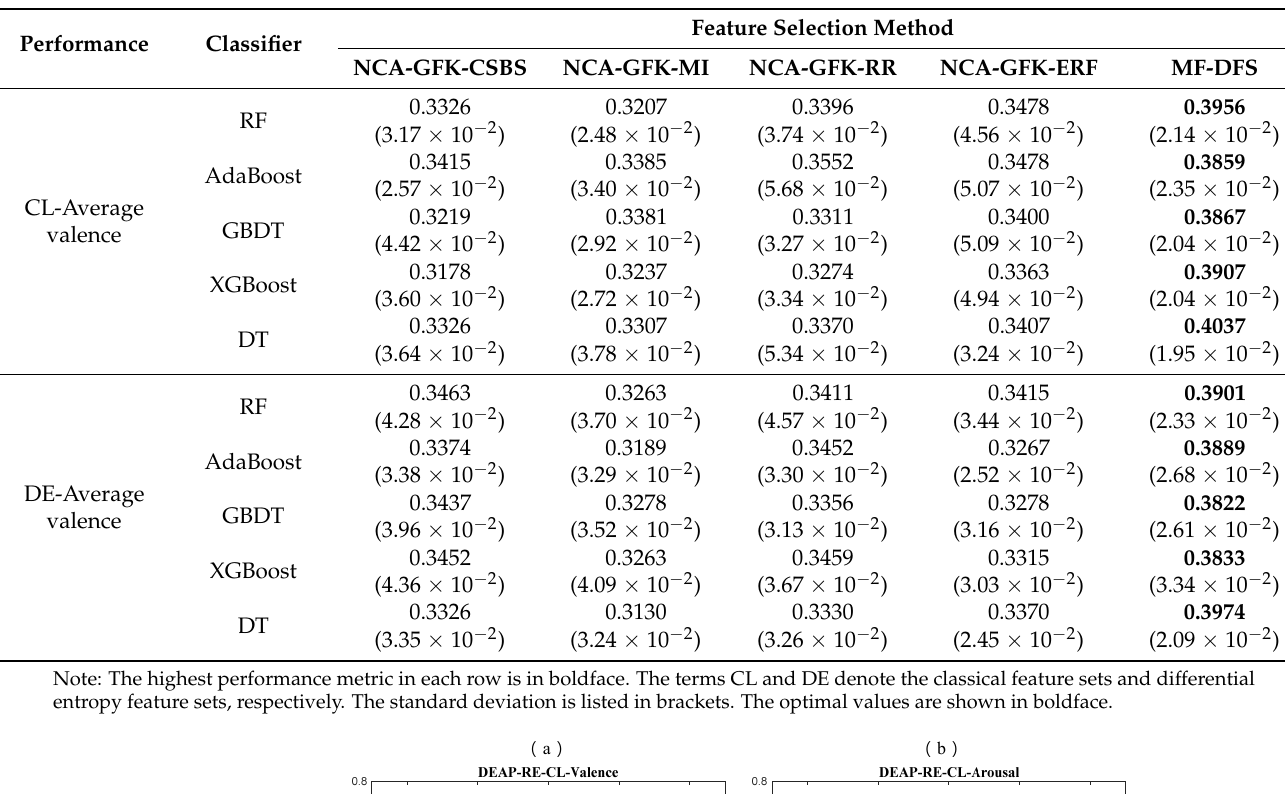
Table 6. Classification performance comparison across different combinations of feature selection methods and machine learning classifiers on the SEED database.